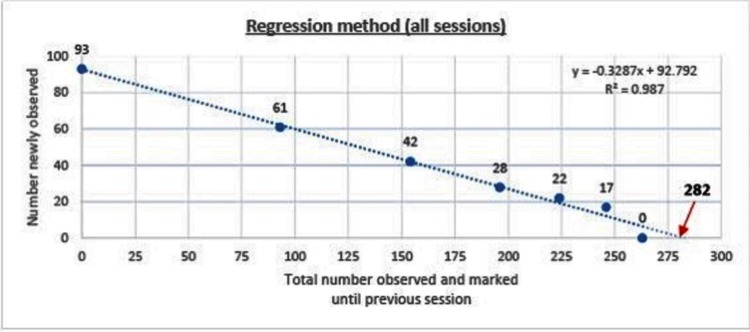
 Prediction of population size of free roaming dogs by regression method for all sessions